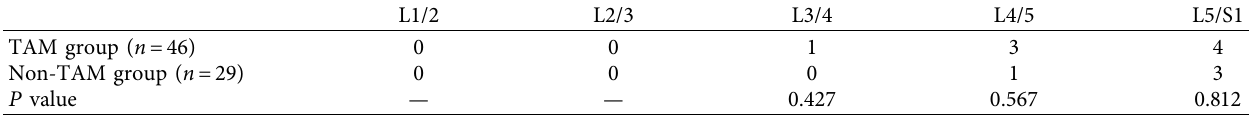
Table 5: Comparisons regarding the occurrence of Modic changes between the TAM group and the non-TAM